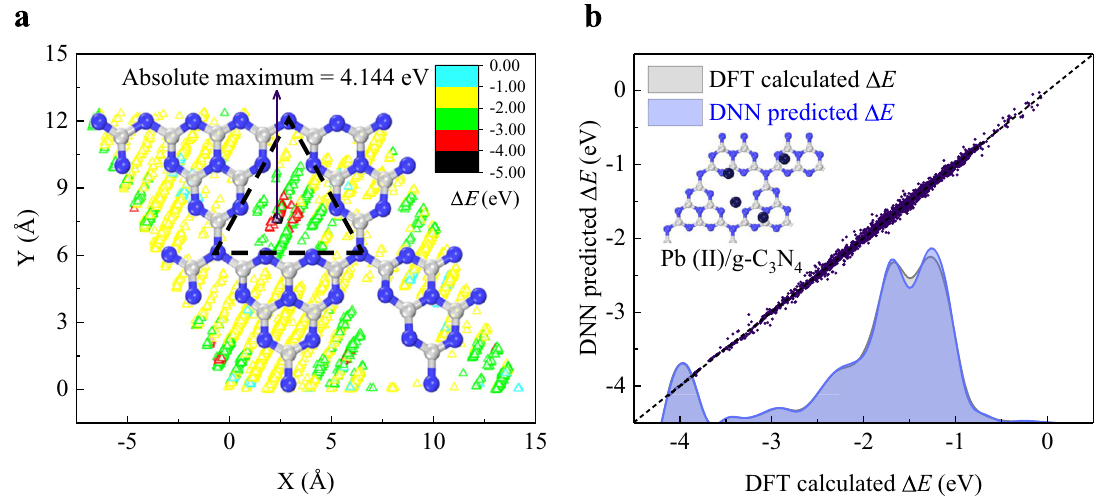
Fig. 2 Dataset of Pb(II)/g-C 3 N 4 and ML results. a Pb(II) position scan at the arbitrary sites of the surface of a parallelogram-shaped g-C 3 N 4 , with the corresponding energy landscape calculated by DFT. The blue, yellow, green, red, and black open triangles represent the adsorption energies from − 0.07 and − 4.144 eV, with the absolute maximum of 4.144 eV. b Correlation plot of adsorption energy against DFT and DNN, along with histograms of predicted (blue) and calculated (gray) energy distributions. Table 1. The RMSEs (eV) and R 2 of Pb(II)/g-C 3 N 4 , Hg(II)/g-C 3 N 4 , and Cd(II)/g-C 3 N 4 , based on DNN and TL methods.